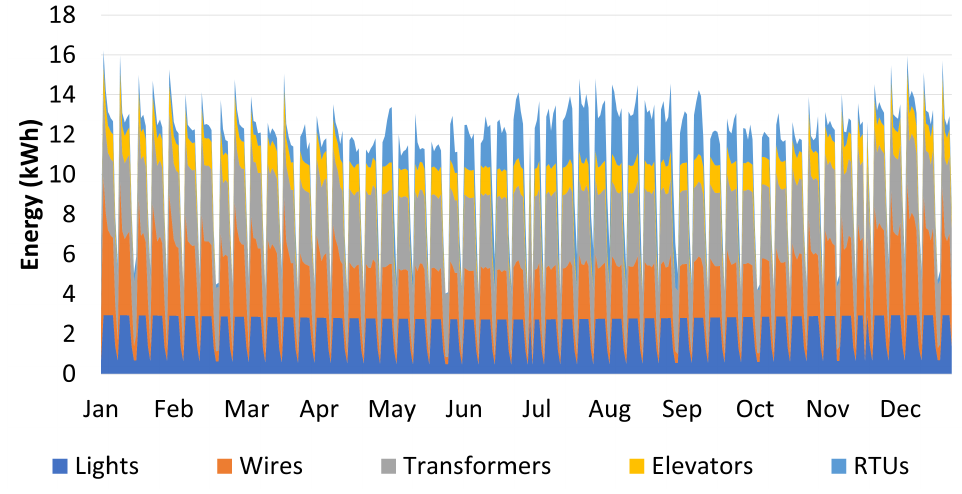
Figure 9. Yearly loss profile (daily average) of different building